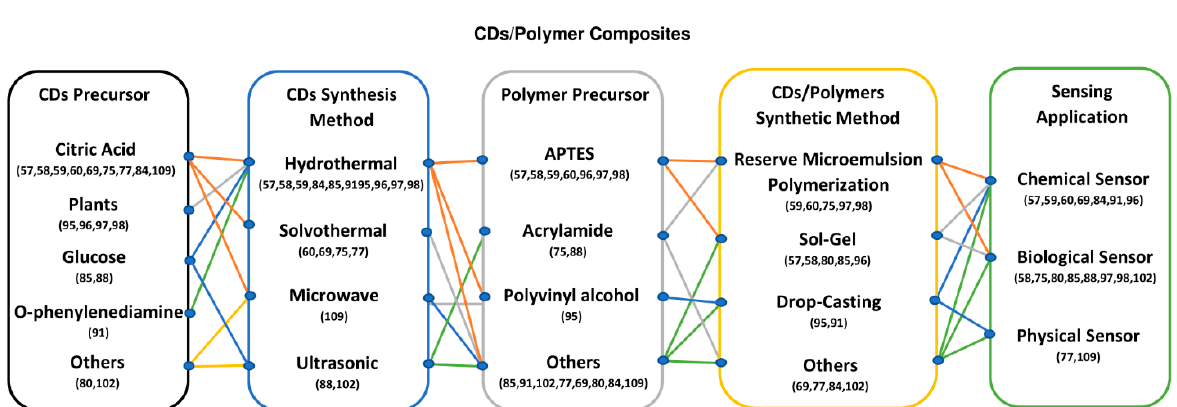
Figure 11. A diagram showing the correlations between the carbon/polymer precursors and synthesis methods of CD/polymer composites based on their sensing applications.